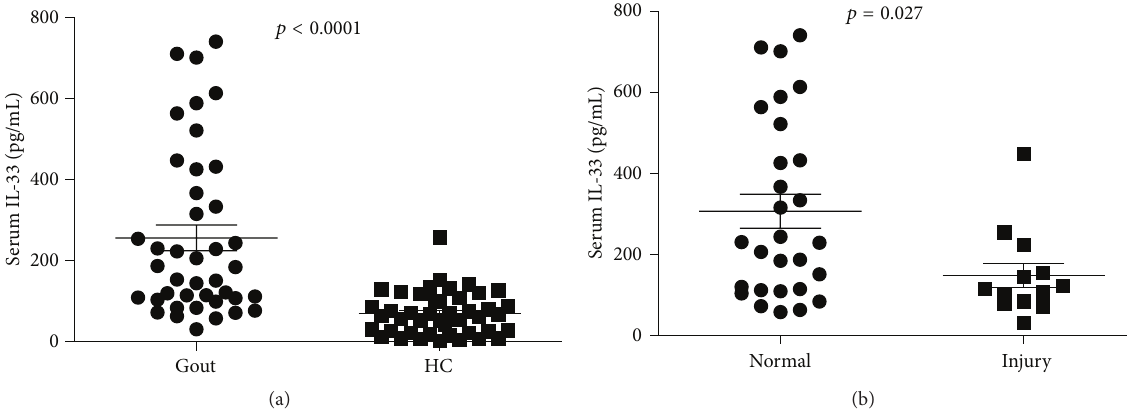
Figure 1: Increased IL-33 expression in gout patients with renal damage. (a) The serum levels of IL-33 in gout patients ( 𝑛 = 41 ) and healthy controls (HC) ( 𝑛 = 44 ) were detected by ELISA; each symbol represented an individual sample and horizontal lines showed median values. (b) The gout patients were divided into two groups, one group with kidney function injury ( 𝑛 = 13 ) and one without ( 𝑛 = 28 ). Mann-Whitney 𝑈 test was conducted to compare the data between two